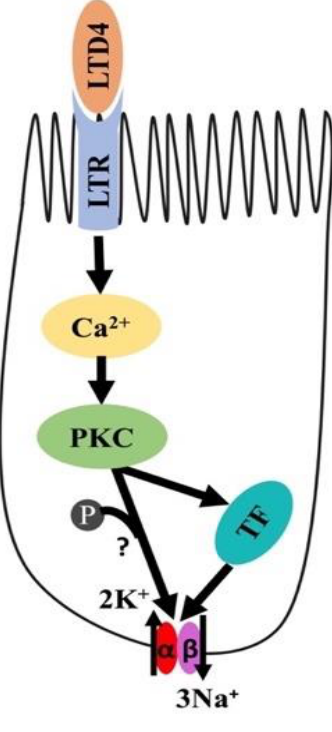
Figure 9. Proposed mechanism of LTD4-mediated regulation of Na-K-ATPase in intestinal epithelial cells. LTD4—leukotriene D4, LTR—leukotriene receptor, PKC—protein kinase C, TF—transcription factor.